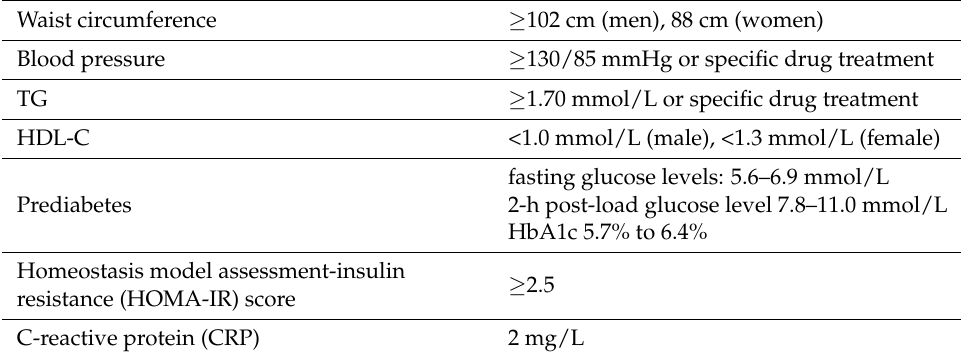
Table 2. Metabolic dysregulation in diagnosis of MAFLD (two or more)